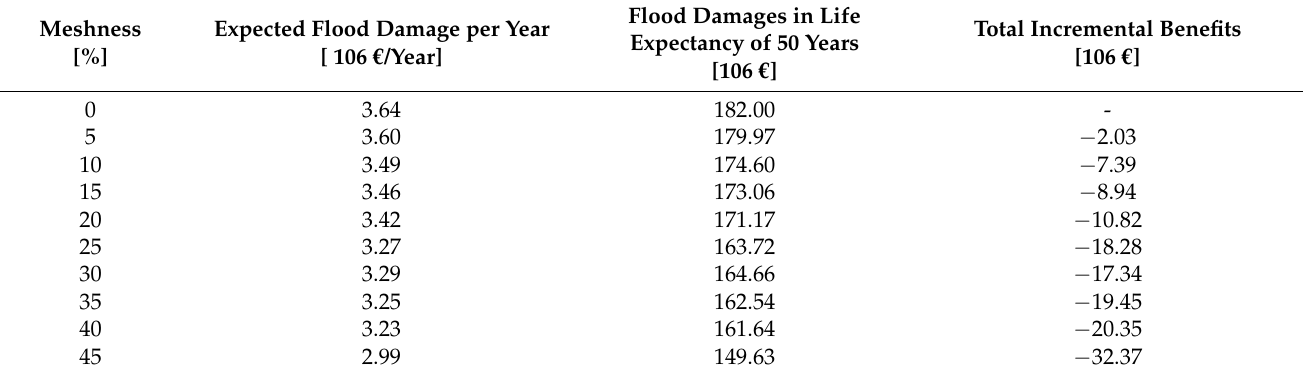
Table 1. Benefits of increasing Meshness in the UDN (Present value in euros 2019). Negative values represent savings due to avoiding flood